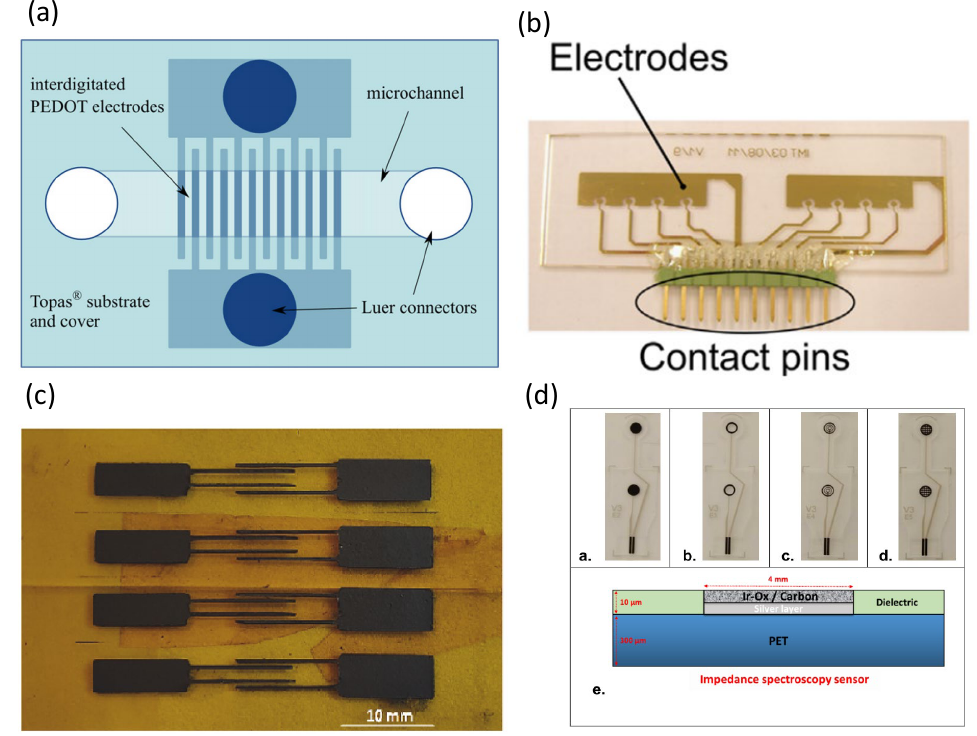
Figure 3. The polymer-based impedance biosensors. ( a ) All-polymer electrochemical microfluidic biosensors are used. Reproduced with permission from [40]. Copyright Biosensors and Bioelectron-